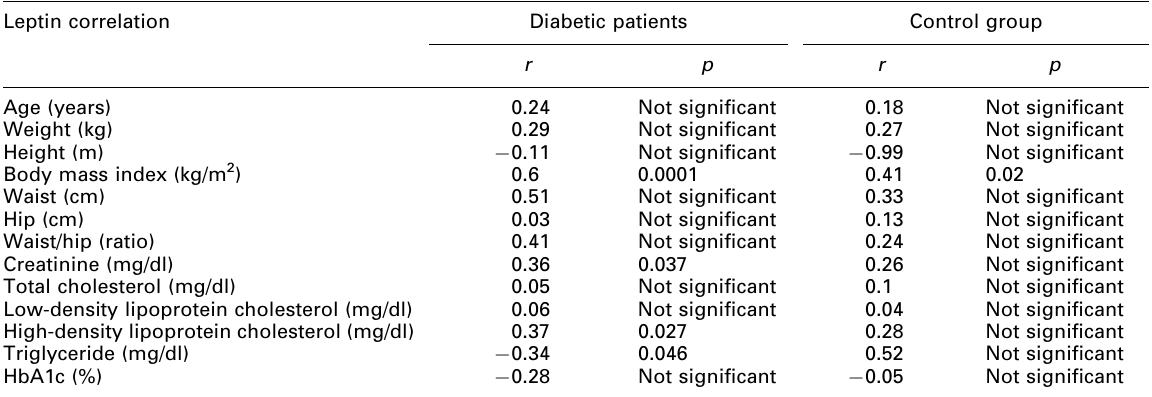
Table 2. Correlations of leptin levels with biochemical parameters in diabetes and control groups Leptin correlation Diabetic patients Control